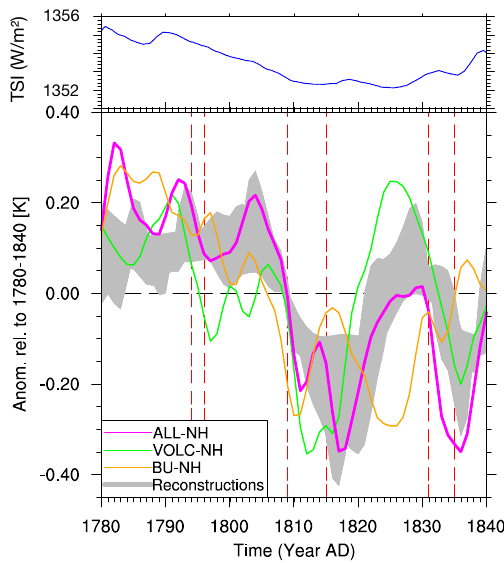
Fig. 6. Top panel: total solar irradiance from the Shapiro et al. (2011) forcing. Lower panel: model comparison with five NH tem- perature reconstructions of the IPCC AR4 (averaged). Magenta, green and orange lines are model curves, the grey envelope the com- posite of a range of tree ring-based reconstructions. Magenta thick: ensemble mean of NH temperatures (ALL-NH). Green: same, but for the VOLC experiment (VOLC-NH). Orange: same, but for the BU experiment (BU-NH). Grey region: envelope of the five NH temperature reconstructions plotted in Fig. S2 in the Supplement. Smoothing of the model results: Gaussian 3years FWHM, centered on year 1. Red vertical dashed lines highlight the years in which a volcanic eruption